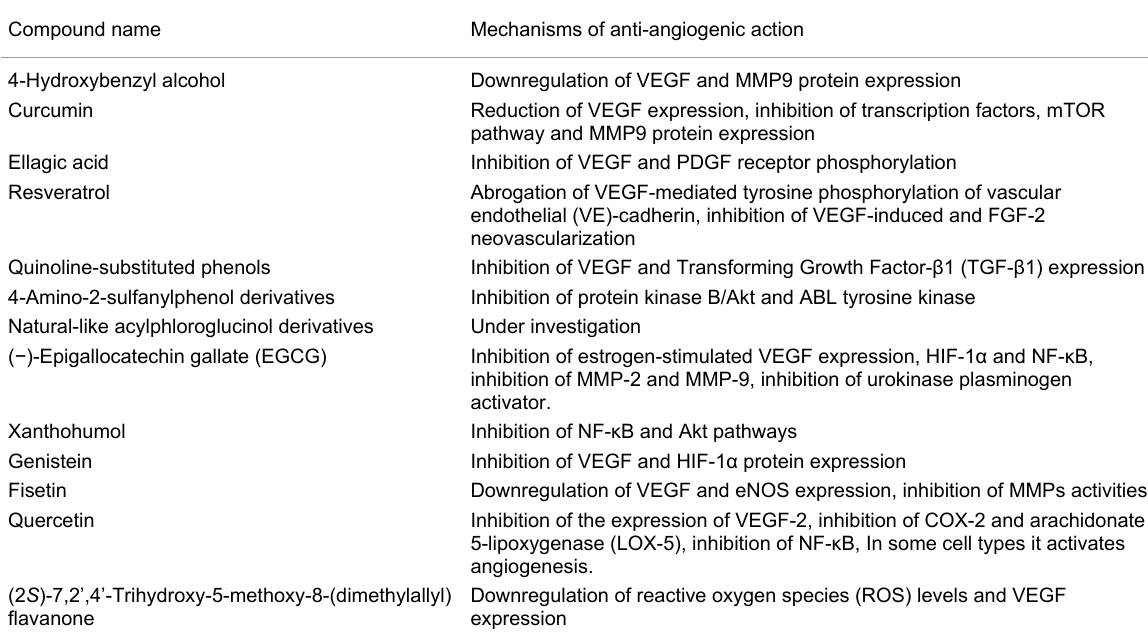
Table 3: Natural phenolic compounds with anti-angiogenic activity and their evaluated molecular mechanisms of anti-angiogenesis.